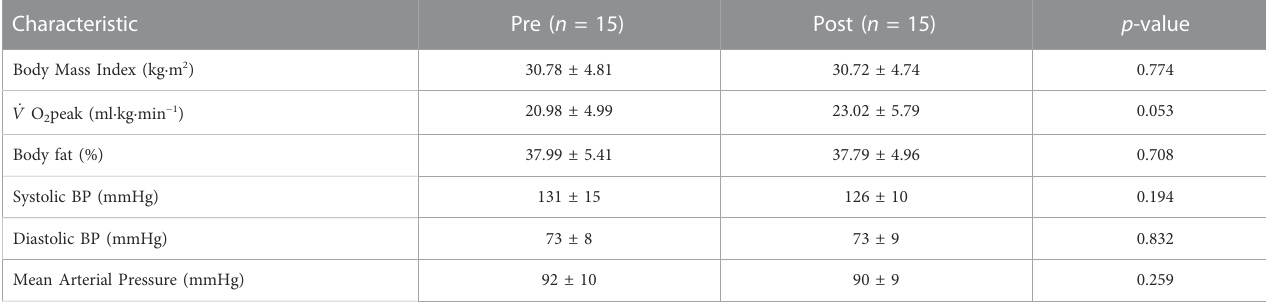
TABLE 1 Participant characteristics before and after 12-week exercise intervention.